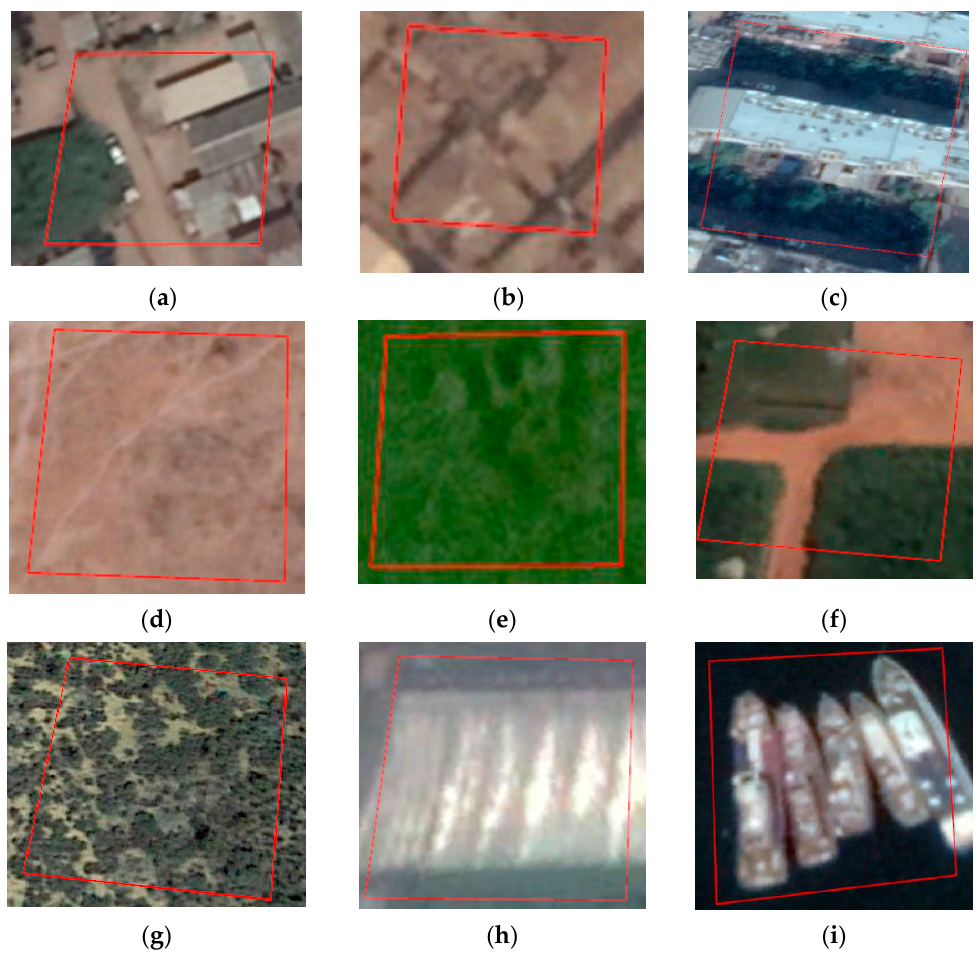
Figure 7. Typical urban and non-urban land covers in the research region (only selected types are shown here). ( a ) Urban land in plain region; ( b ) Urban in arid area; ( c ) Urban land with high density; ( d ) Greenhouse; ( e ) Grass; ( f ) Grass with soil as background; ( g ) Shrub; ( h ) Greenhouse; ( i ) Water body with ships in